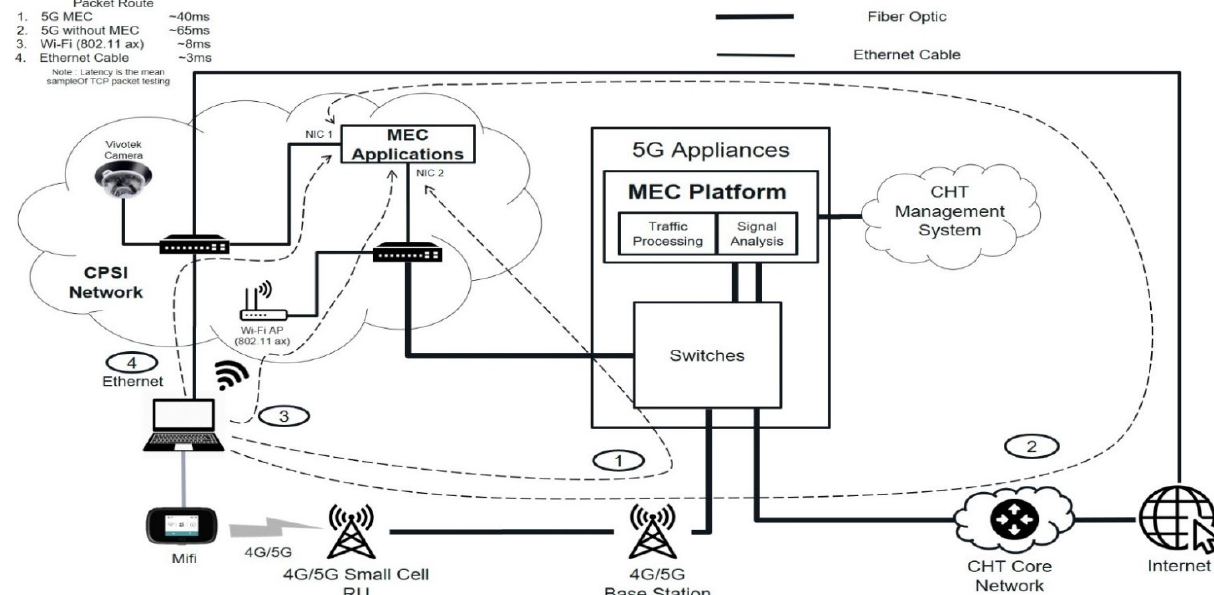
Figure 2. 5G network architecture and data transmission route: 1 (cid:13) 5G MES, 2 (cid:13) 5G without MEC, 3 (cid:13) WiFi 6, (802.11ax) 4 (cid:13) Ethernet.